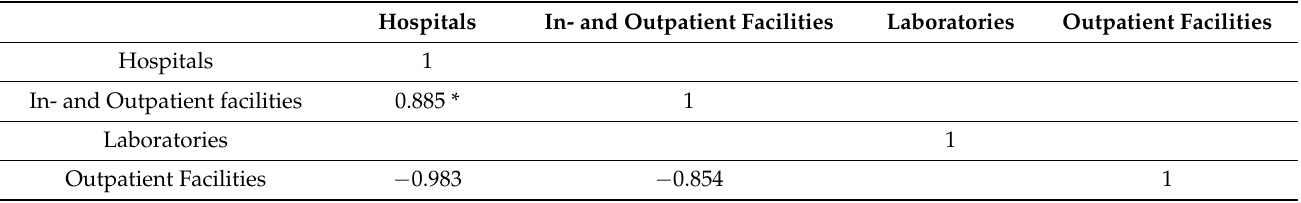
Table 7. Correlation matrix, Western